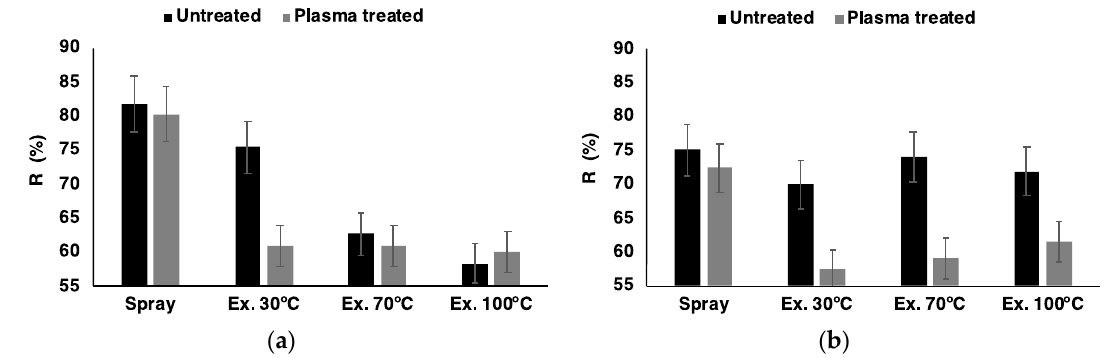
Figure 2. Diffuse reflectance (%) at 420 nm for the untreated and dielectric barrier discharge (DBD) plasma-treated samples with poly(N-vinylpyrrolidone)-coated silver nanoparticles (PVP–AgNPs) before washing ( a ) and after five washing cycles ( b ).